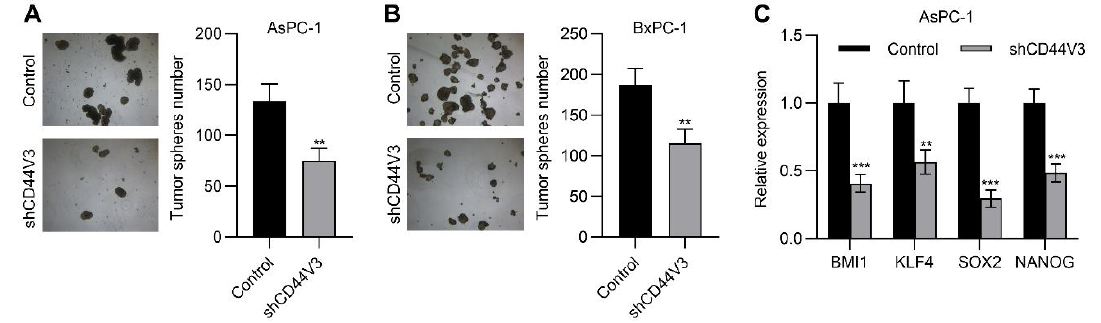
Figure 5. Downregulation of CD44V3 inhibited pancreatic cancer cell stemness. ( A ) Tumor spheres formation assay of AsPC-1 cells transfected with CD44V3 shRNA. ( B ) Tumor sphere formation assay of BxPC-3 cells transfected with CD44V3 shRNA. ( C ) A panel of stem cell markers in AsPC-1 cell transfected with CD44V3 shRNA was determined by qPCR. The data are presented as mean ± S.D. ** p < 0.01; *** p < 0.001.